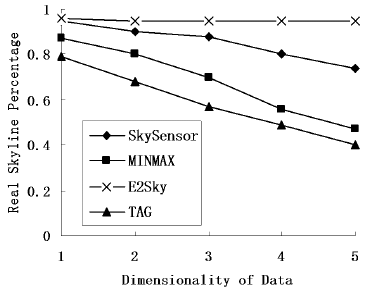
Figure 9. Real skyline percentage under different data dimensionality.